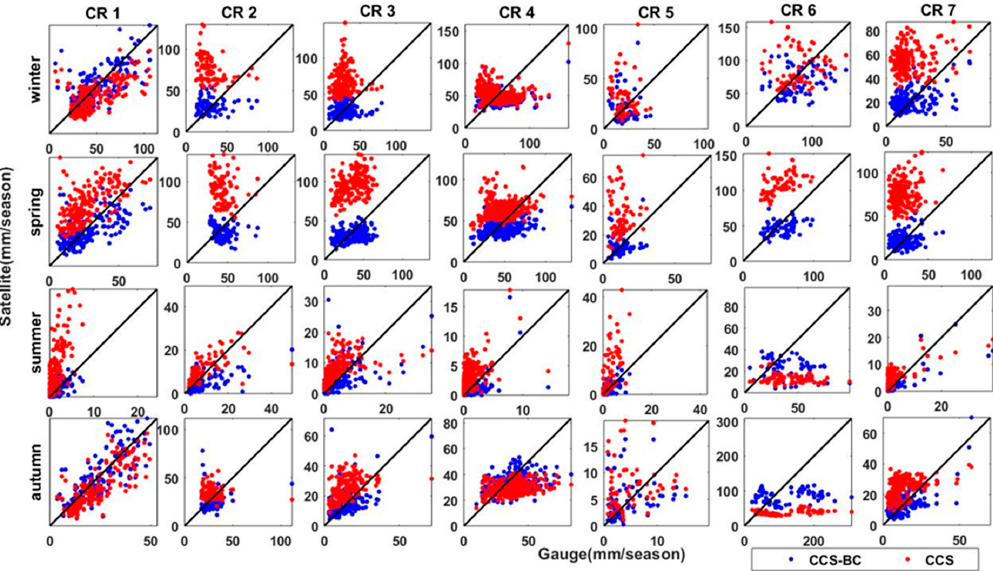
Figure 6. Scatter plots of the CCS and CCS-BC mean seasonal precipitations versus the gauge mean seasonal precipitation in gauged pixels for seven CRs for the calibration period.